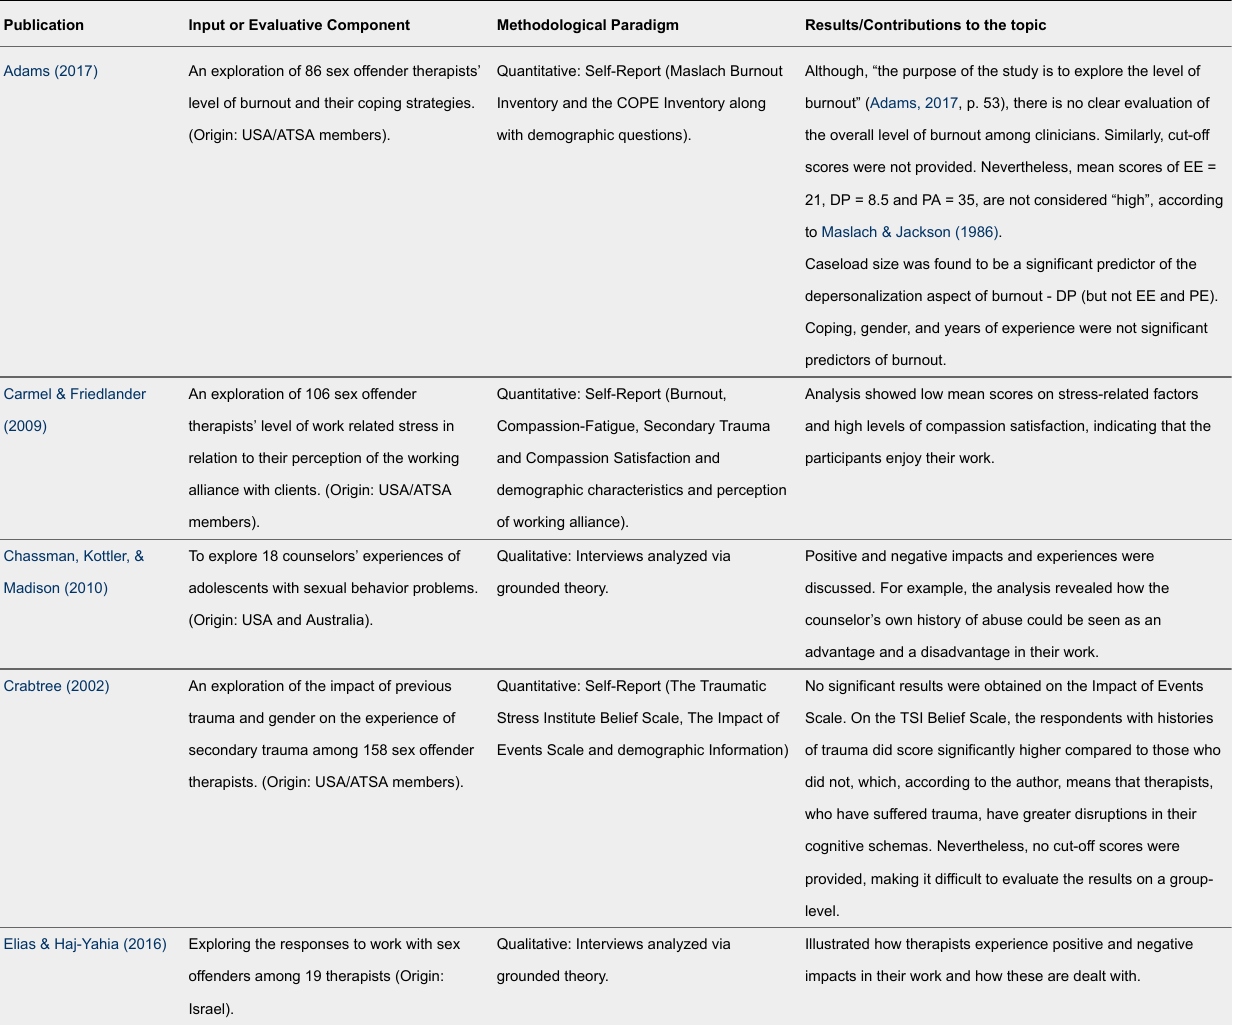
Description of Empirical Studies Directly Referring to the Experience of Working With Sex-Offenders and/or People With